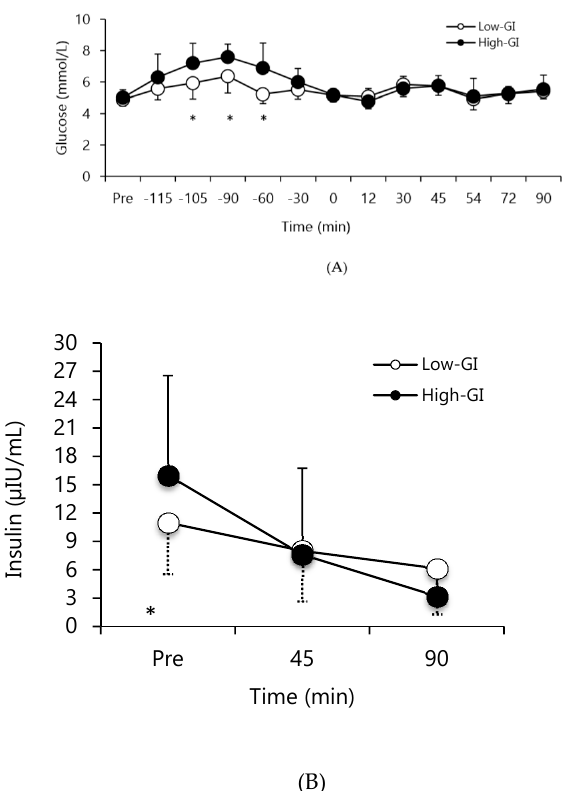
Figure 3. ( A ) Plasma glucose concentrations before and during the simulated soccer match, ( B ) Insulin concentration before, at half time, and at the end of the simulated soccer match (* p < 0.05 low-GI vs. high-GI sport nutrition bar). “Pre” denotes fingertip blood sample collection prior to consumption of the sport nutrition